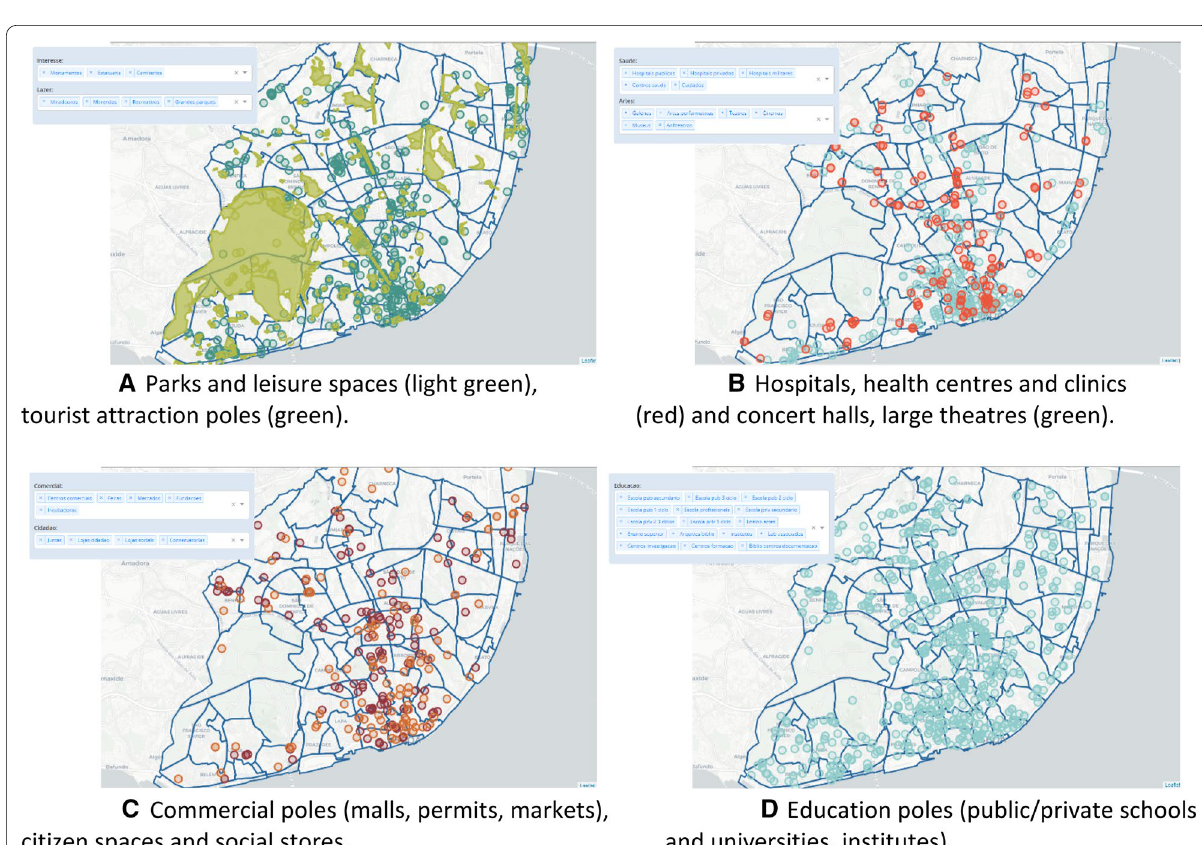
Fig. 12 a Parks and leisure spaces (light green), b Hospitals, health centres and clinics tourist attraction poles (green). (red) and concert halls, large theatres (green). c Commercial poles (malls, permits, markets), d Education poles (public/private schools citizen spaces and social stores